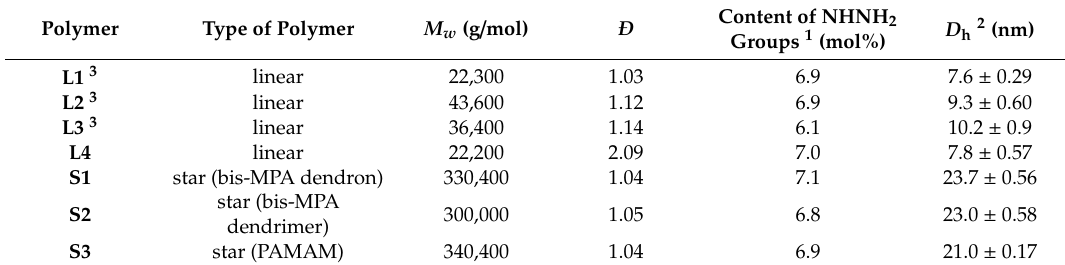
Table 1. Physico-chemical characteristics of N -(2-hydroxypropyl)methacrylamide (HPMA)-based polymer